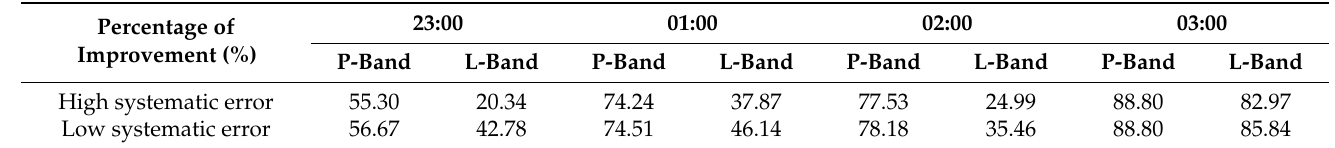
Table 3. Evaluation results of Figures 8 and 9.